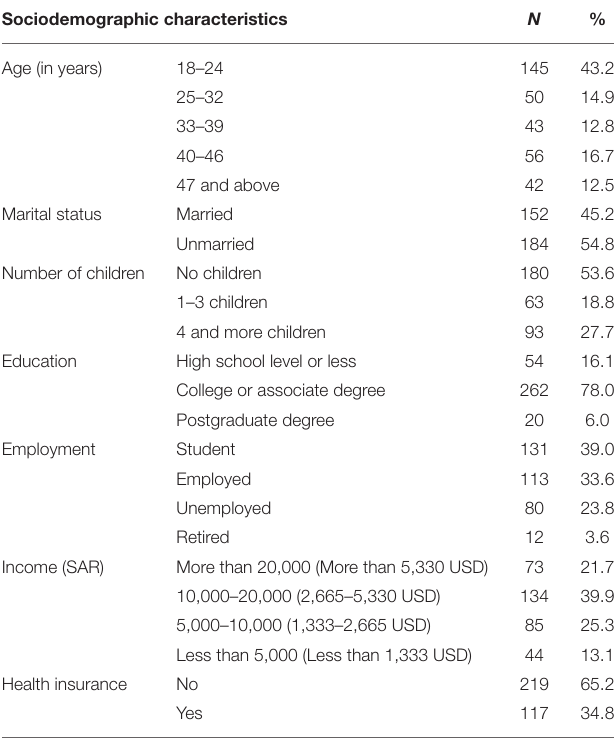
TABLE 1 | Sociodemographic characteristics of Saudi women ( N =